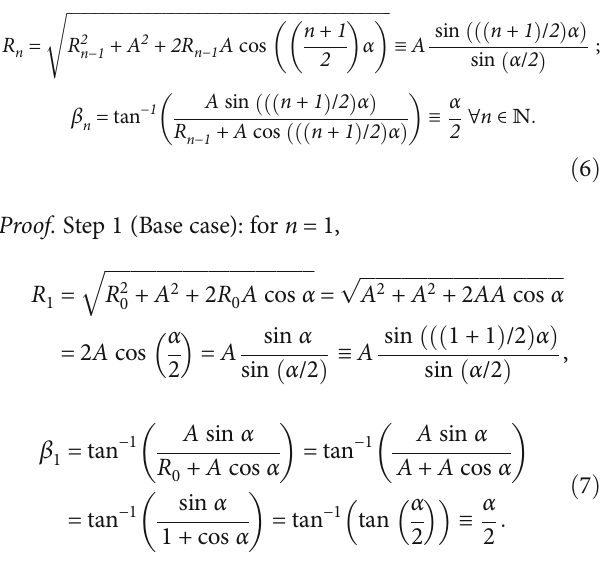
α , α , α , ⋯ , α 1 2 3 N − 1 g , (b) successive resultants f Table 1: The quantitative relationship of summed phasors, resultants, and iterations of the parallelogram